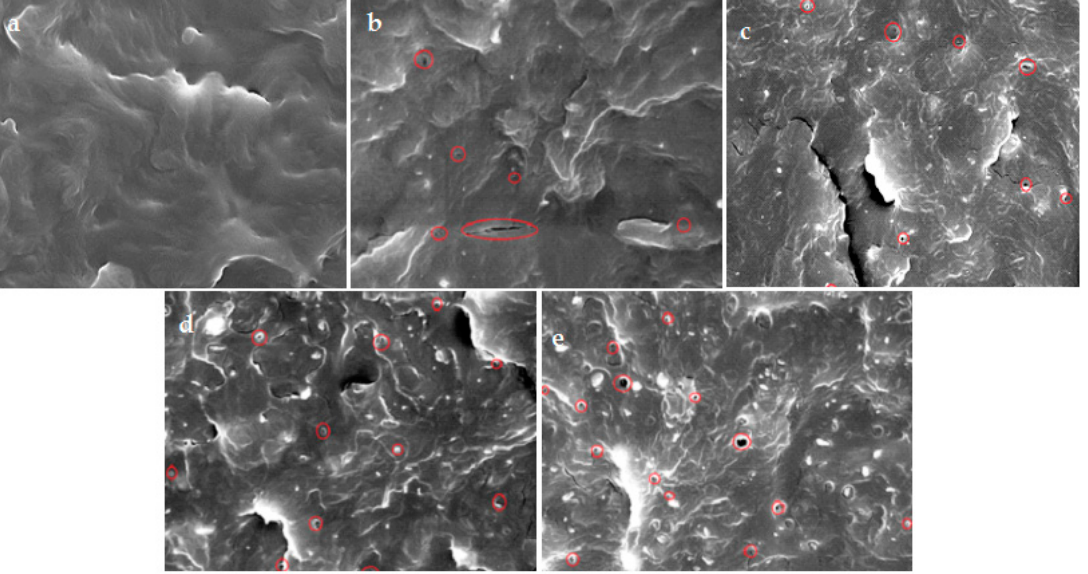
Figure 7. FTIR analysis of the halloysite [82].